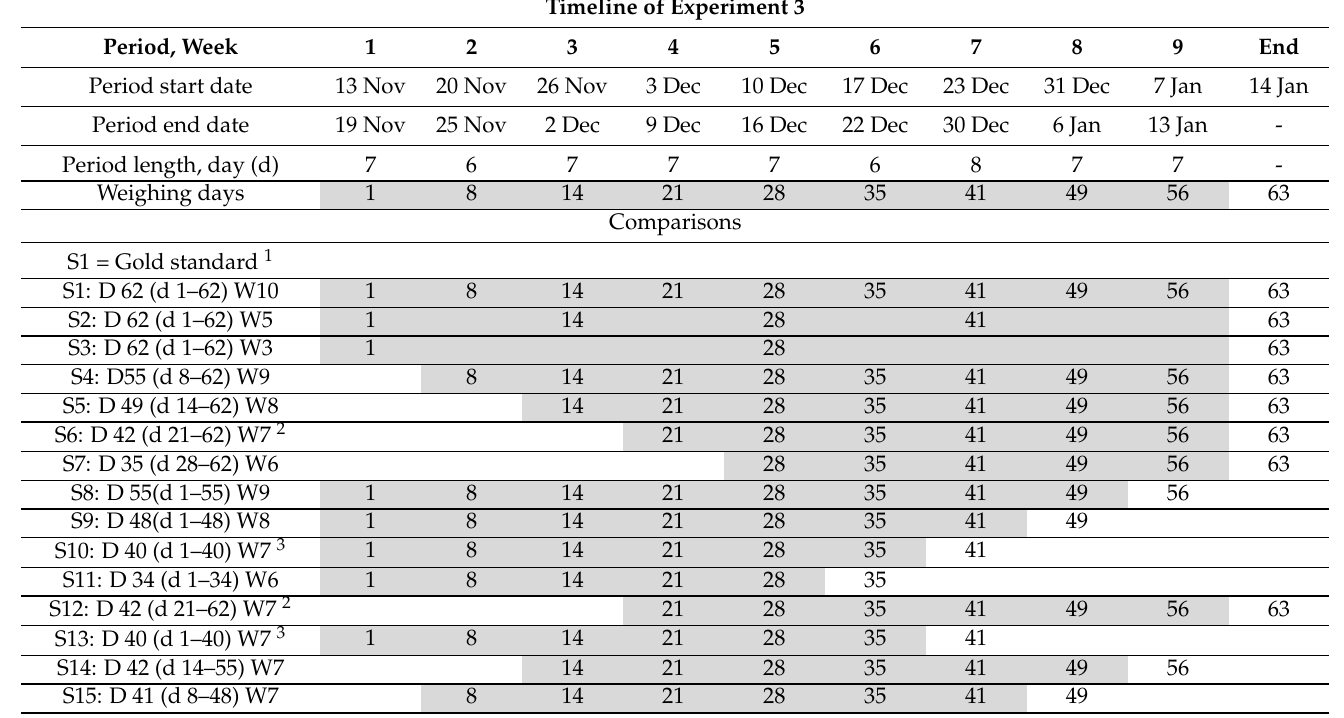
Table 3. Timeline and comparisons of the standards (or data subsets) (S1–15) of experiment 3 with beef breed bulls (52 Aberdeen Angus and 52 Simmental). Standards S1–15 varied in terms of the duration of test periods (d) and the number of times the animals were weighed (W). Note that in the description of the standards, D refers to the total duration of the test period for standards S1–15 and d refers to the order of the days in S1. Start day of the experiment (d 1) was the day when feed intake measurements were initiated. The grey shading indicates the periods from which the daily dry matter intake data were used. The numbers in the cells of each data subset indicate the weighing days for that test period.